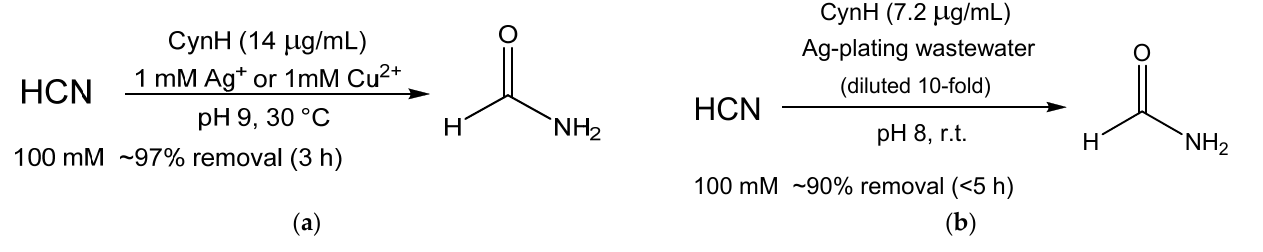
14 of 20 Figure 6. Removal of free cyanide (fCN) and phenol compounds (phenol, m -cresol, and p -cresol)